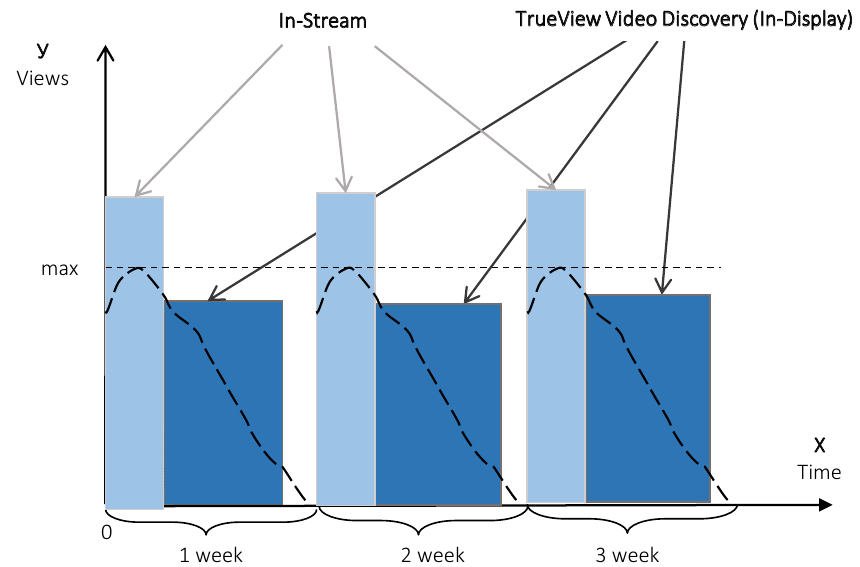
Figure 13. Synergistic effects of advertising reviews (dashed lines) in a consistent advertisement broadcasting system: In-Stream and TrueView Video Discovery (In-Display)